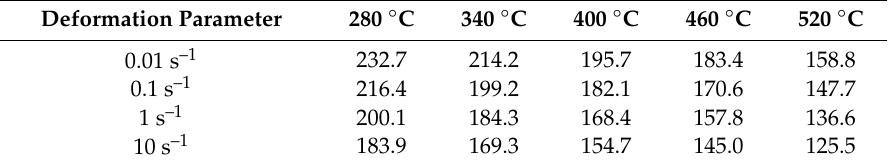
Table 3. The deformation activity energy at di ff erent hot deformation conditions.